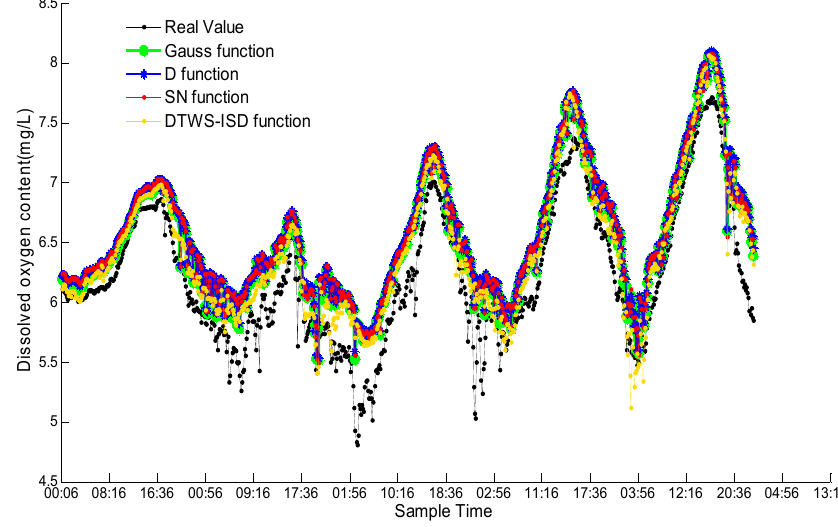
Figure 7. Comparison between DTWS-ISD with three existing functions.